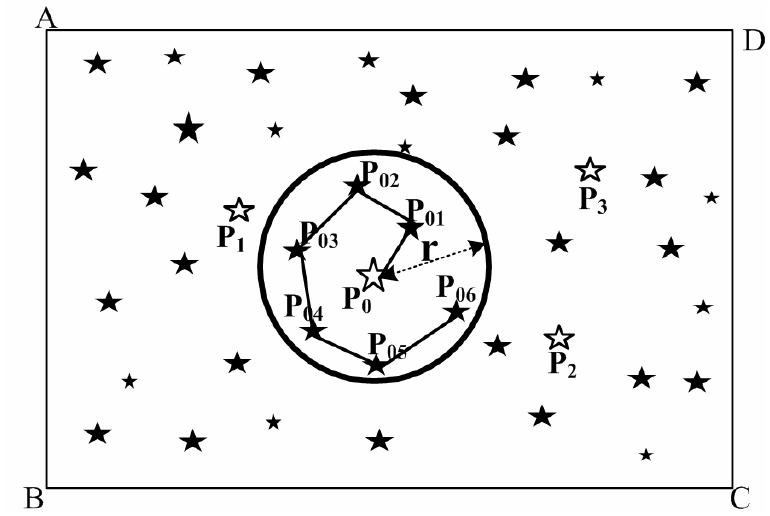
Figure 3. The Optimal route map of light points in circle by the